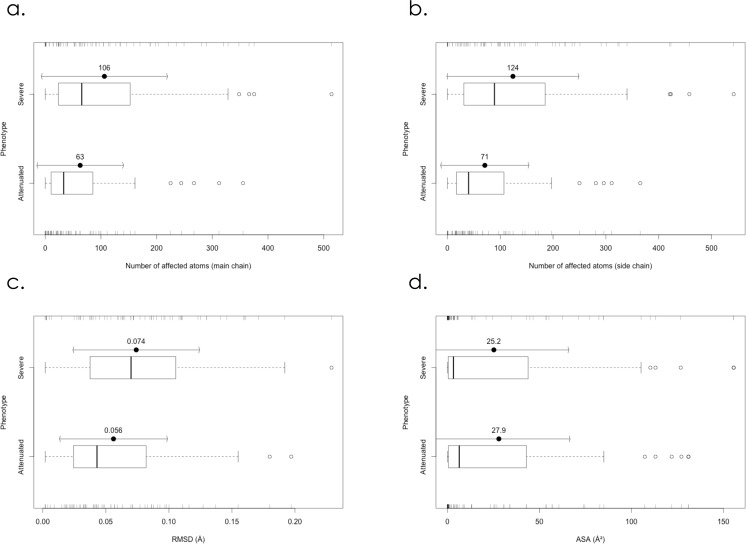
Boxplots of numbers of atoms affected by amino acid substitutions in the main chain (a) and the side chain (b), RMSD values between mutant and wild type IDS proteins (c), and ASA of amino acid residues where substitutions responsible for MPS II occur (d). Severe: Severe group. Attenuated: Attenuated group.